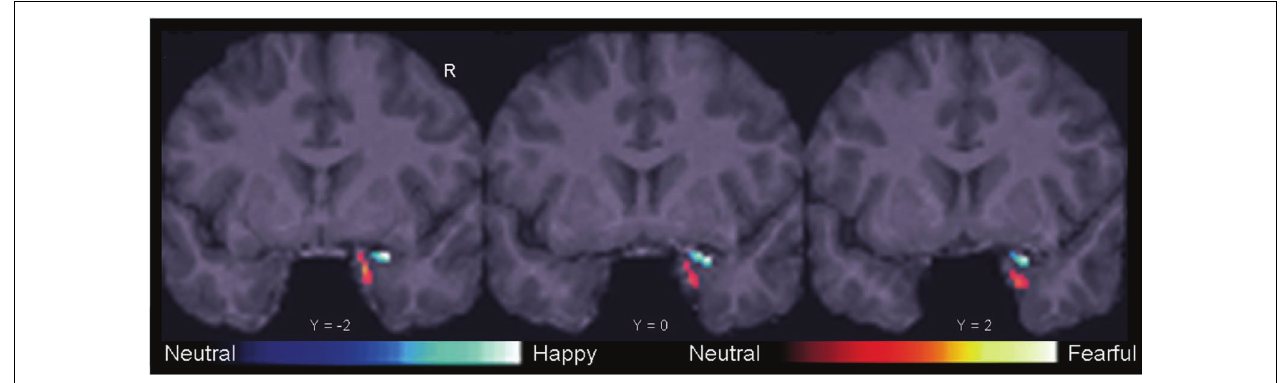
group are designated by cold colors (blue).Voxels of greater activation in response to fearful versus neutral facial expressions in theTD group are designated by hot colors (orange). Adapted from Haas et al. (2009) Journal of